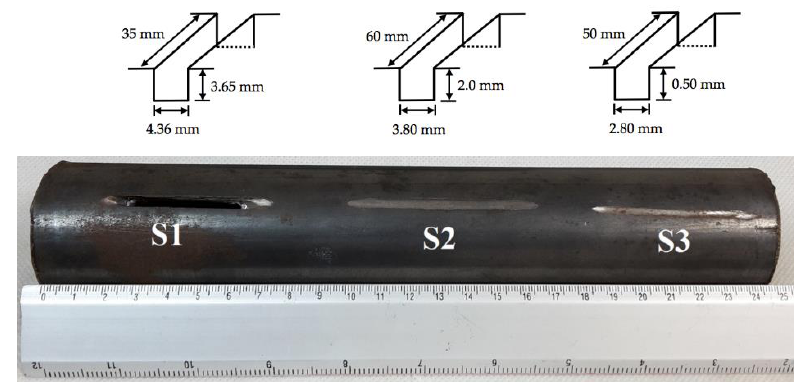
Figure 4. Dimensions of three rectangular defects of the ASTM A-36 steel pipe.